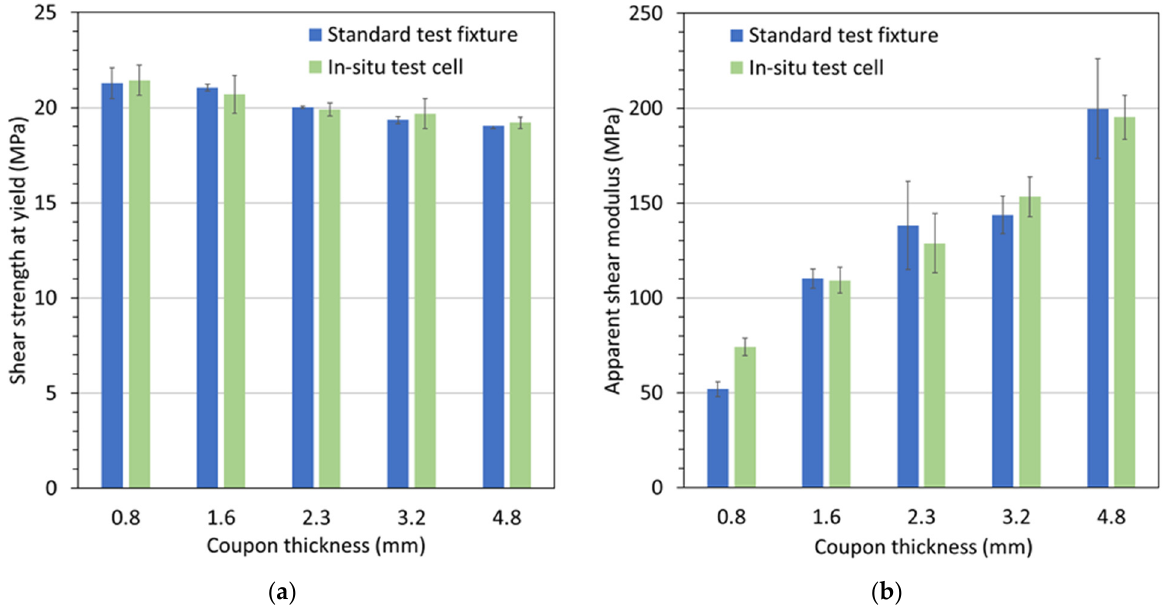
Figure 4. Comparison of ( a ) shear strengths at yield and ( b ) apparent shear moduli, obtained from testing with the standard punch-shear fixture and the in situ punch-shear-test cell, for coupons with different thicknesses made of Polymer A1.